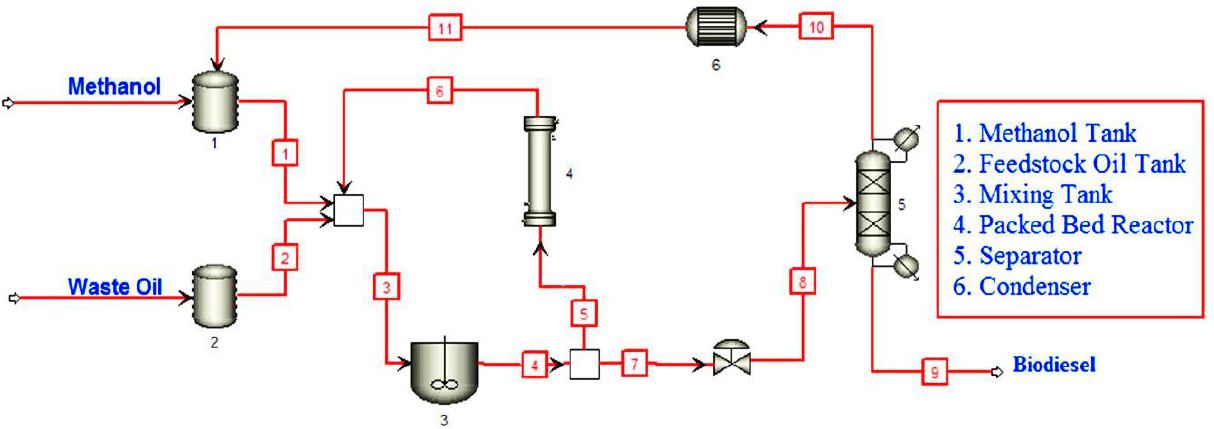
Figure 1. Schematic diagram of packed bed reactor (PBR) for continuous process for biodiesel